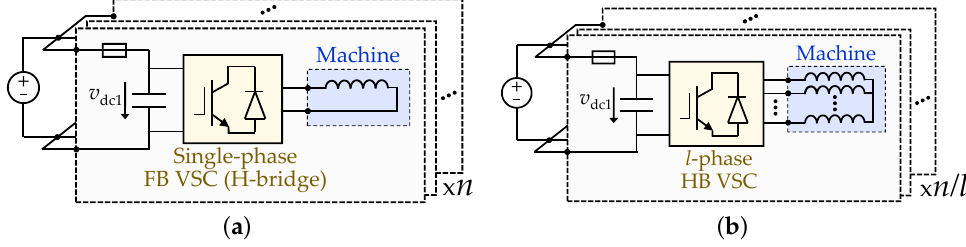
Figure 40. Topologies for tolerating dc-link capacitor faults based on modular VSC with fuses and parallel capacitors. ( a ) For H-bridge modules, as in [130]. ( b ) For l -phase HB modules, as in